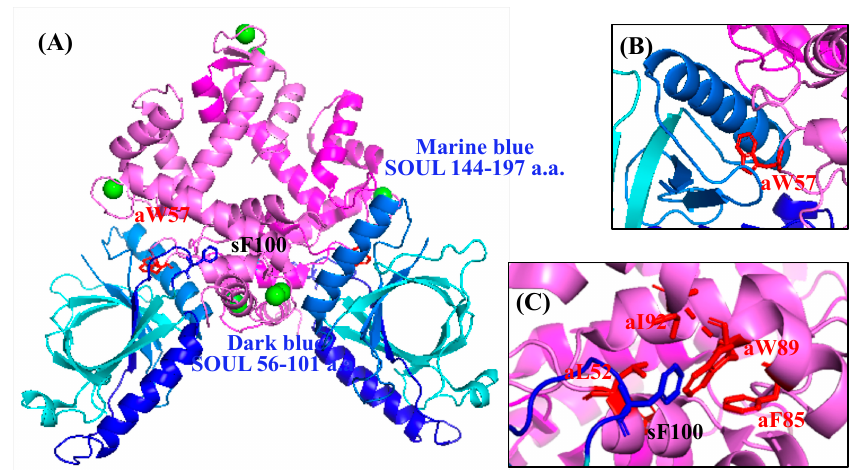
Figure 6. Structure of the human SOUL/ALG-2 complex. ( A ) Location of SOUL56-101, Phe100 of SOUL and Trp57 of ALG-2 in the structure of the tetrameric SOUL/ALG-2 complex (PDB code: 5gqq) [13]. Blue, SOUL; dark blue, SOUL56-101 amino acids; marine blue, SOUL144-197 amino acids that were deleted in a SOUL1-143 mutant; sF100, SOUL Phe100; pink, ALG-2; aW57, ALG-2 Trp57; green boles, Ca 2+ ions. ( B ) Interaction sites of ALG-2 Trp57 with the SOUL C-terminal region. ( C ) Interaction sites of SOUL Phe100 in a hydrophobic pocket (pocket 3) of ALG-2.